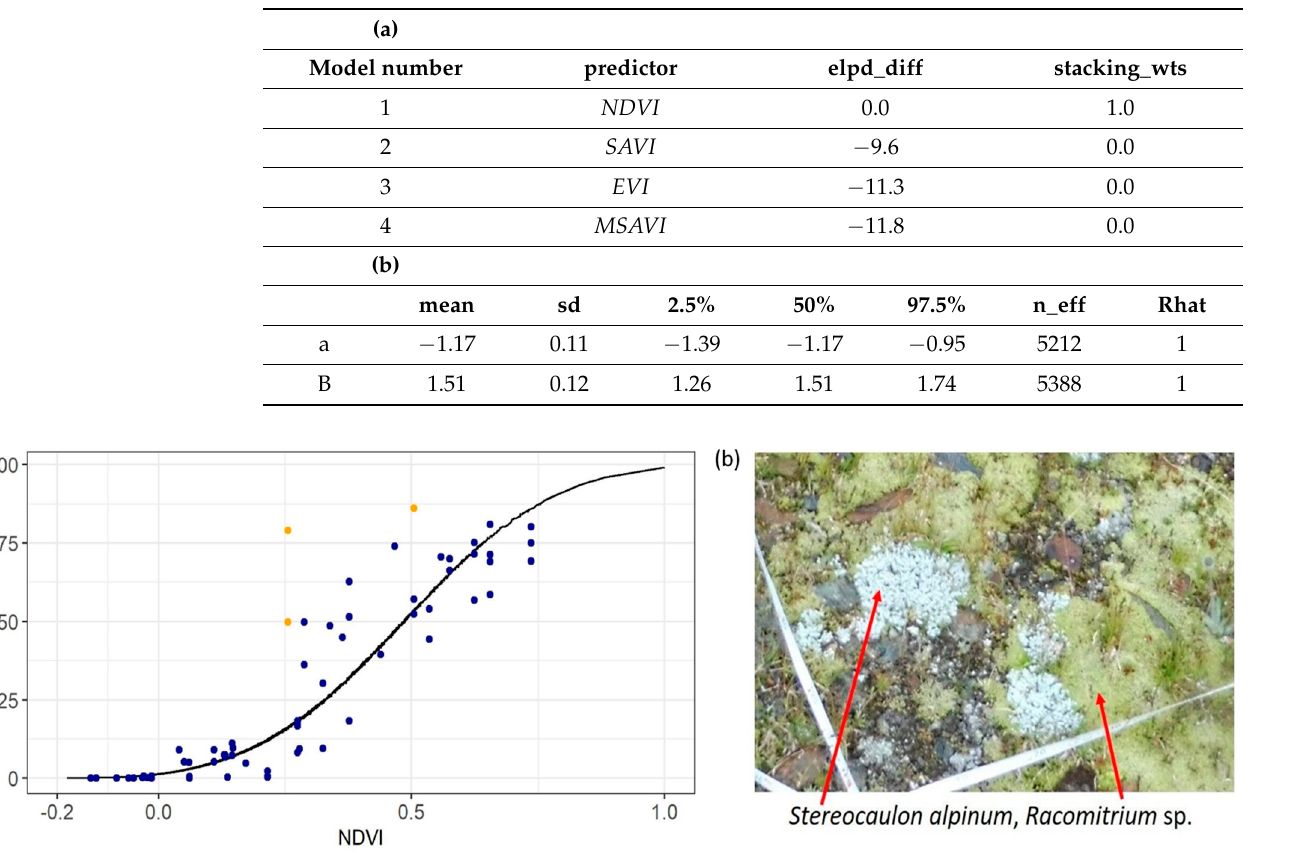
Figure 3. Comparison of the NDVI -based predicted vegetation cover and the in-situ vegetation cover. The graph ( a ) shows that the median of the predicted vegetation cover (%) (black line) fits well to the in-situ vegetation cover (%) (blue points). The yellow points mark the three plots with the largest deviation from the model results. These plots ( b ) had high cover values of Racomitrium sp. and Stereocaulon alpinum . The image ( b ) was taken during the field campaign in 2020.